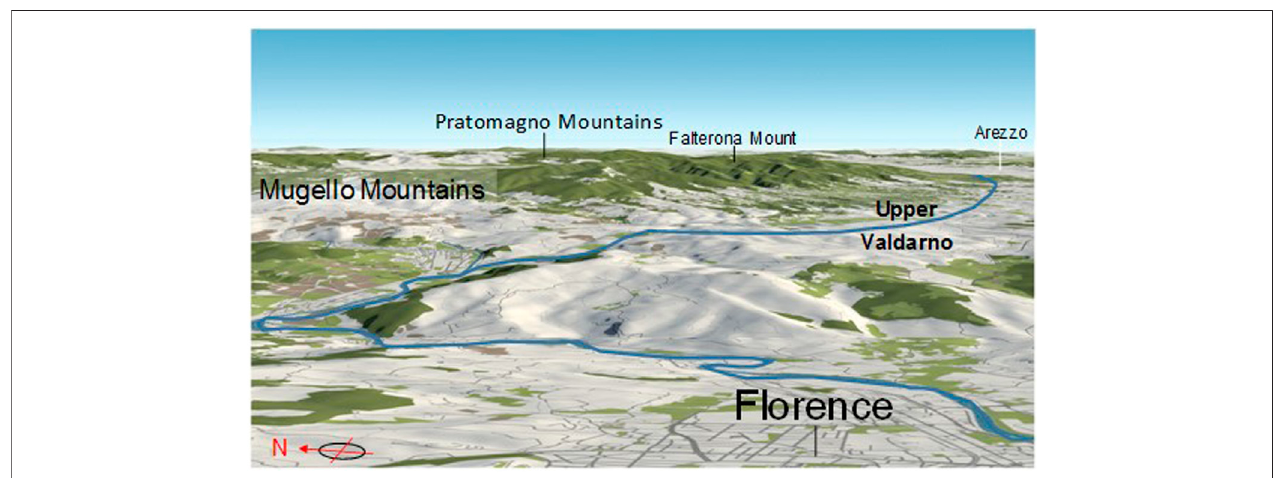
FIGURE3 | PerspectiveviewofArno River Basin from theeast. The highest elevations are found on theMount Falterona (43 ° 52 ′ N, 11 ° 42 ′ E, 1654 m a.s.l.) and the mountainous group of Pratomagno, where they reach 1658 m a.s.l. on Monte Falco (43 ° 52 ′ N, 11 ° 42 ′ E), 1592 m a.s.l. on Croce di Pratomagno (43 ° 39 ′ N, 11 ° 39 ′ E)